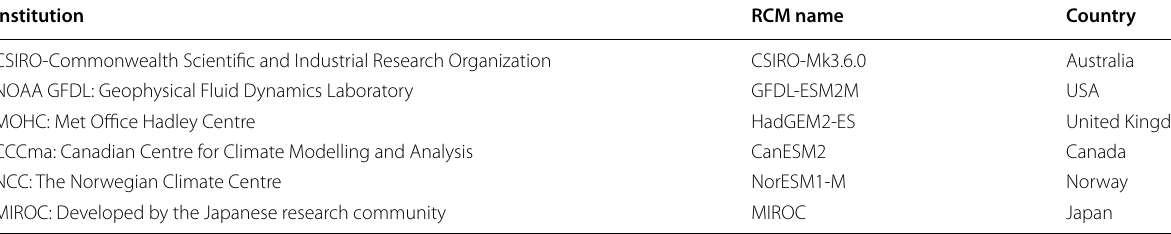
Table 5 Regional Climate Models (RCMs) in the CORDEX-Africa used in this